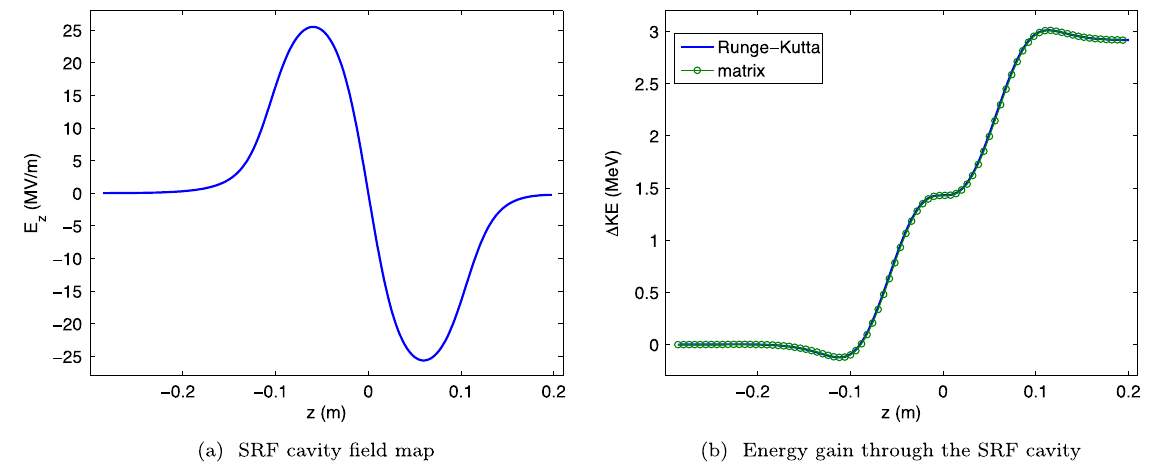
FIG. 3. The field map for the SRF injector cavity and the corresponding energy gain. The cavity voltage is 3 MV, the initial kinetic energy is 1 MeV, and the phase is